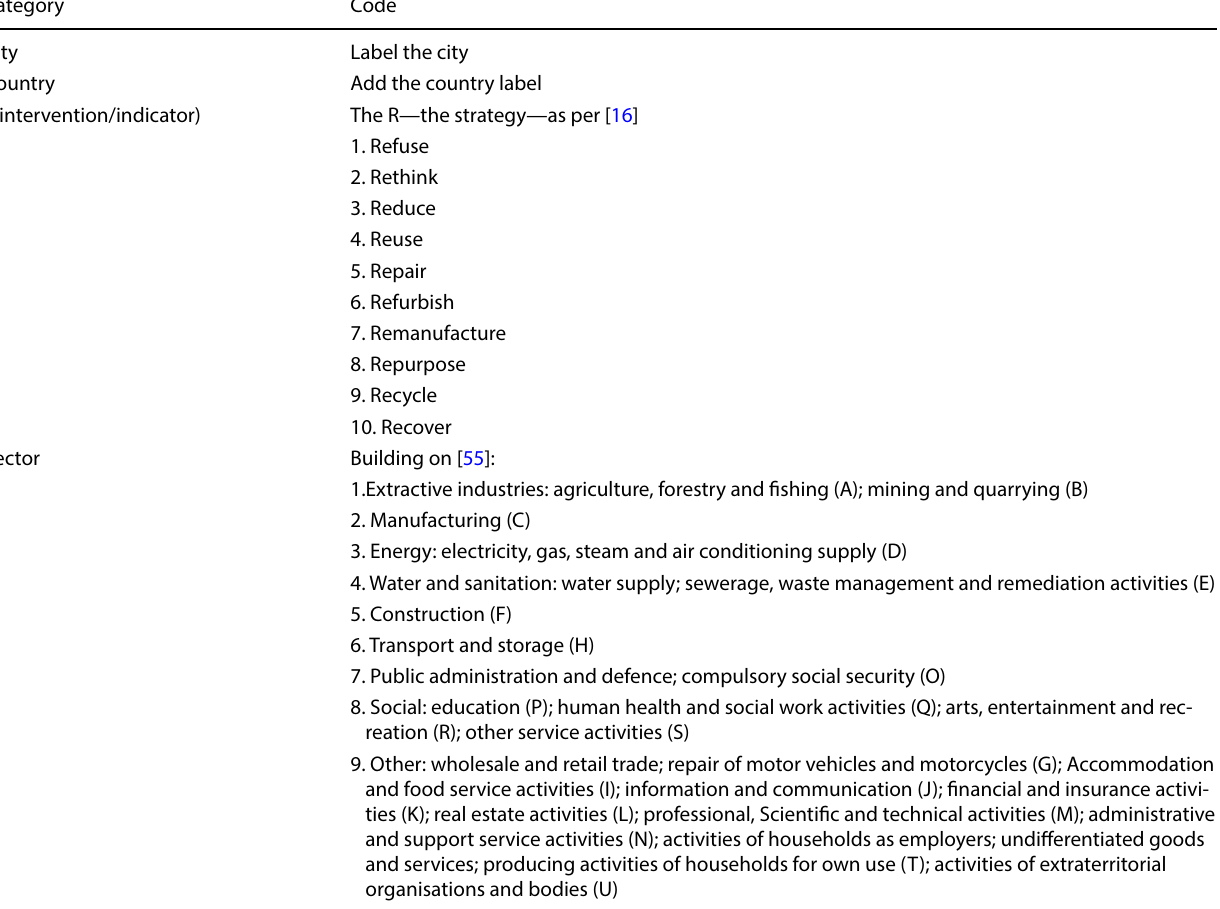
Table 4 Codebook for our data extraction